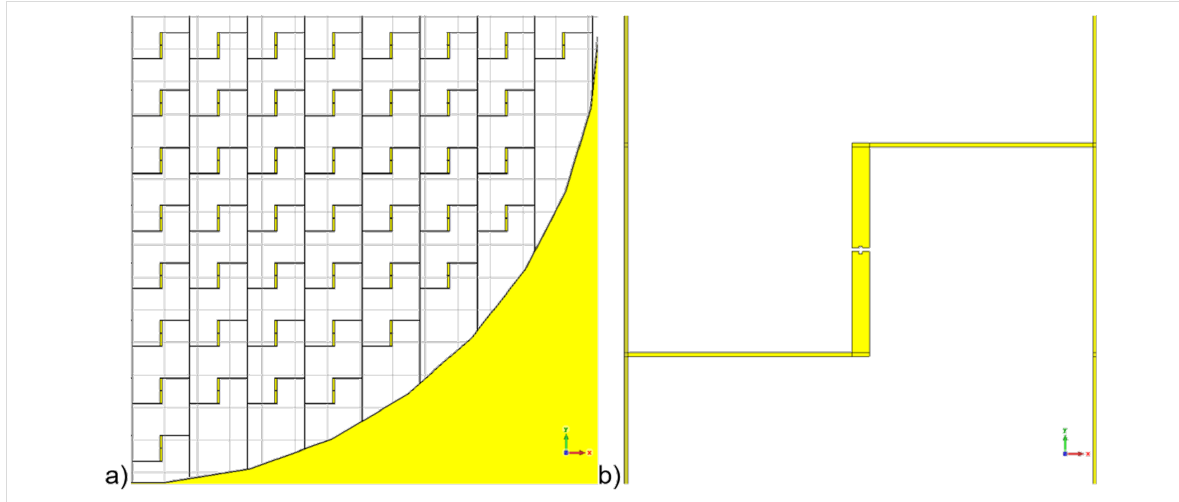
Figure 3: Receiving system of the LSPE-SWIPE145 GHz main channel. a) A quarter of receiving cells matrix on the 14 mm chip. b) A single cell of the receiving system based on a dipole antenna.